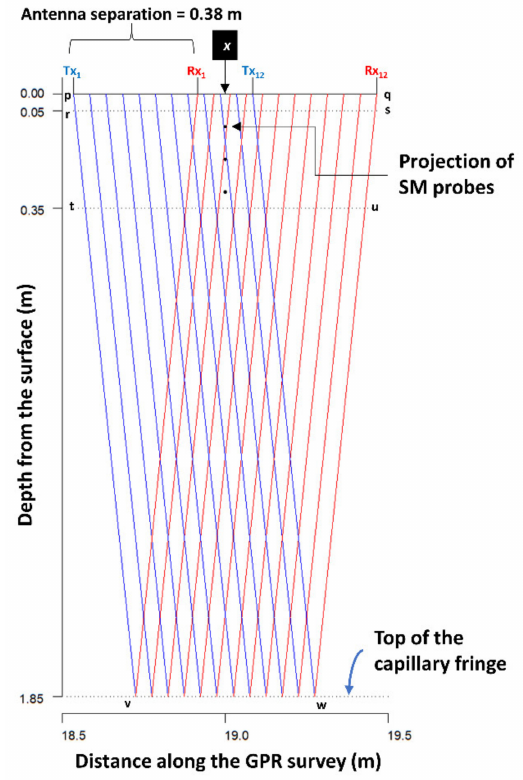
Figure 10. Ground penetrating radar (GPR) wave paths related to twelve GPR traces at the intersection of the GPR survey line and the A–A 1 plane. A 250 MHz CO survey with 0.38 m antenna separation and 0.05 m sampling interval was considered. Tx 1 and Tx 12 = transmitter positions, Rx 1 and Rx 12 = receiver positions, corresponding to first and twelfth trace. x = intersection of A–A 1 plane (refer to Figure 2b). Note that GPR wave paths are assumed to be